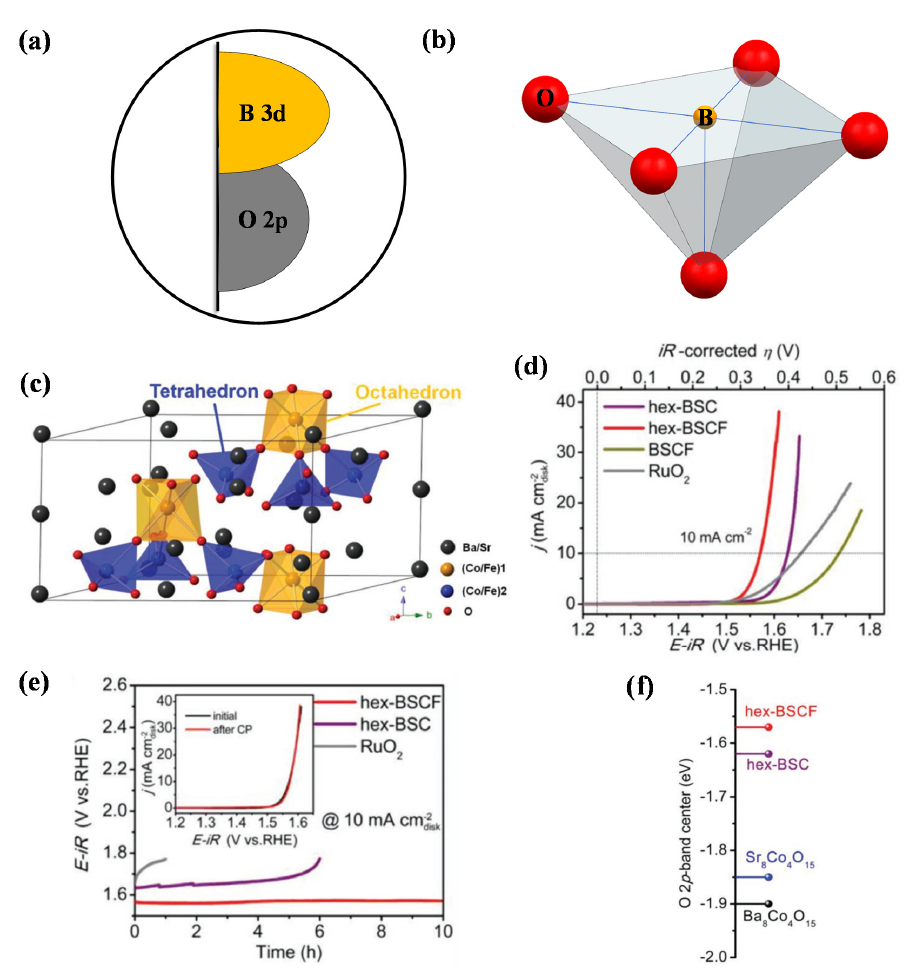
Figure 8. ( a ) Electronic structure of perovskites. ( b ) BO 5 configuration. ( c ) Perspective view of the crystal structure of the hex-BSCF. ( d ) Capacitance- and ohmic resistance-corrected polarization curves of hex-BSC, hex-BSCF, BSCF, and RuO 2 catalysts in an O 2 -saturated 0.1 M KOH solution at a scan rate of 10 mV s − 1 . ( f ) Chronopotentiometric (CP) curves of the hex-BSCF, hex-BSC, and RuO 2 catalysts at 10 mA cm − 2disk . The inset in ( e ) is the polarization curves of the hex-BSCF before and after the CP test. ( f ) Calculated O 2 p -band center relative to the Fermi level. Reproduced with permission from ref. [97], Copyright 2019, Wiley.